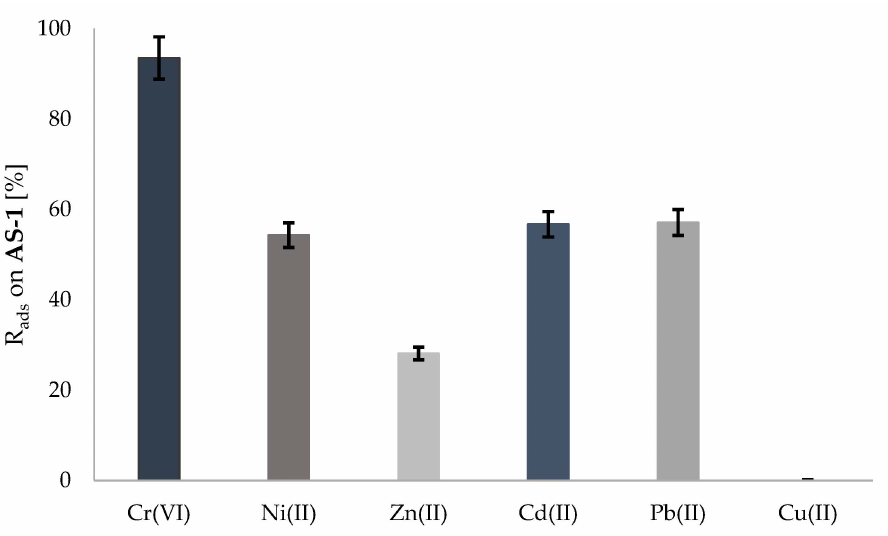
Figure 2. Sorption of metal ions on the active substrate ( AS-1 ) according to experiment